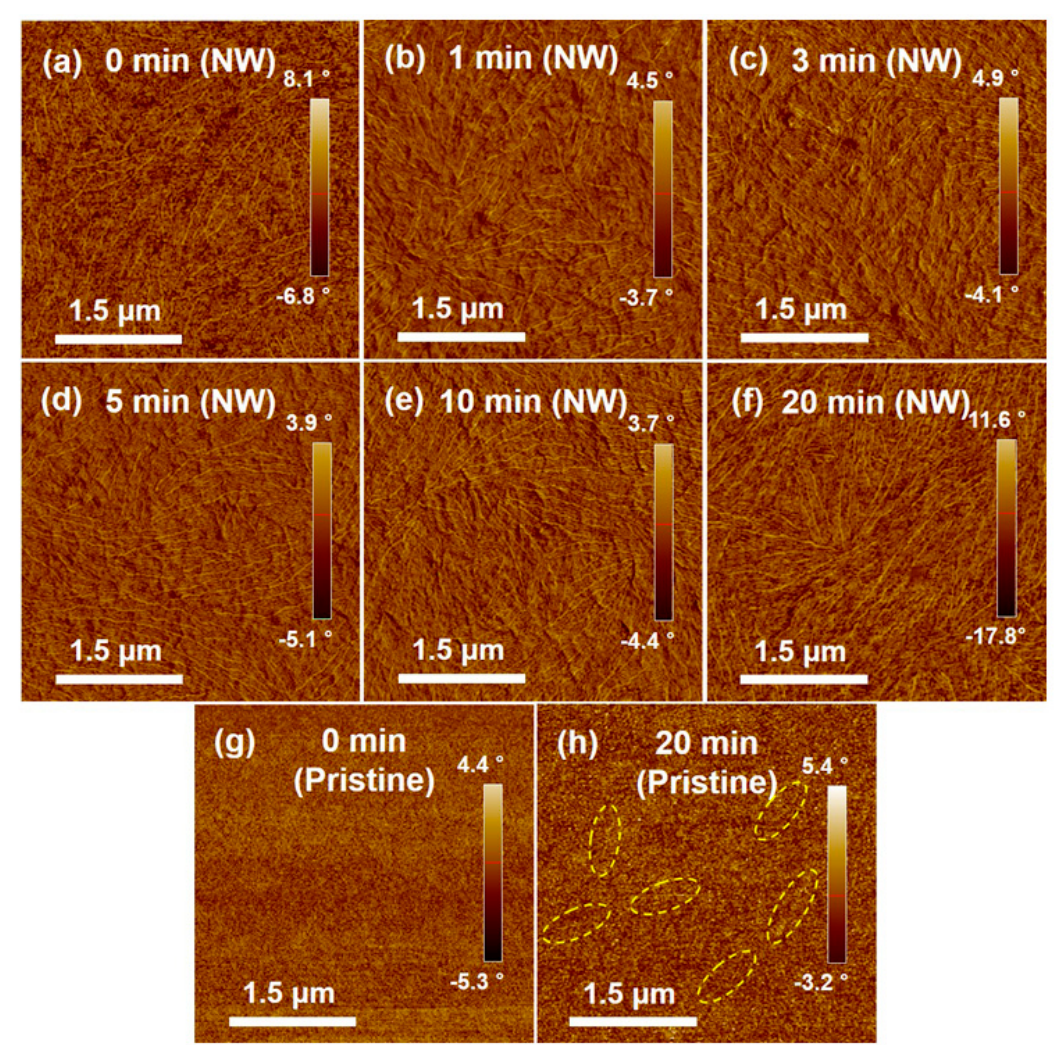
Figure 2. Tapping-mode atomic force microscopy (AFM) images of spin-coated P3HT-NW-embedded P3HT thin films annealed by chloroform (CF) vapor for ( a ) 0, ( b ) 1, ( c ) 3, ( d ) 5, ( e ) 10, and ( f ) 20 min, and spin-coated pristine P3HT films annealed by CF vapor for ( g ) 0 and ( h ) 20 min. The dotted yellow circle surrounds one of the NW-like P3HT